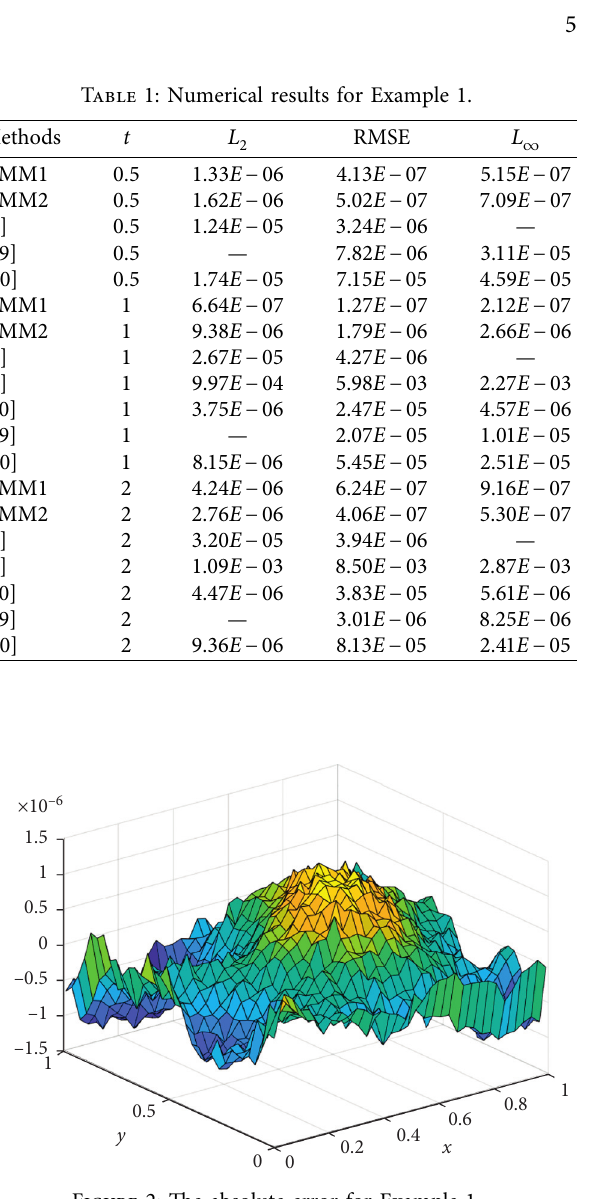
Figure 2: The absolute error for Example